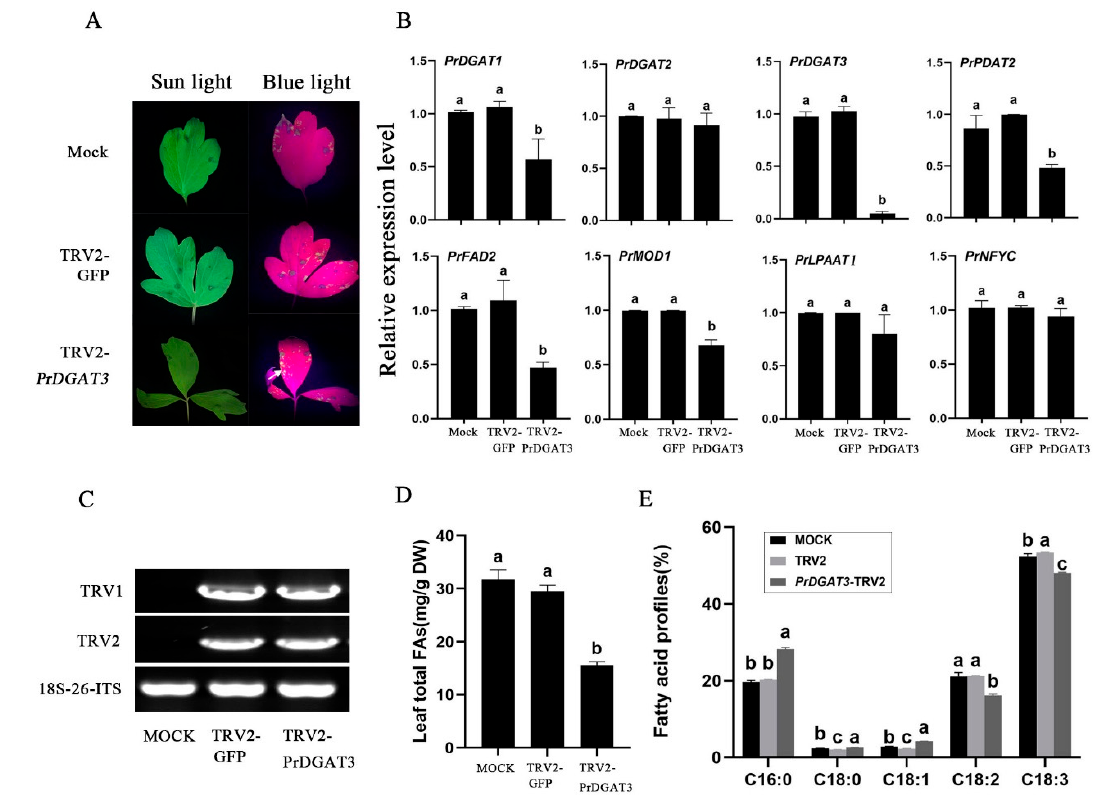
Figure 5. Reduced expression of PrDGAT3 in Paeonia rockii reduces the oil content and affects fatty acid composition as well as relative gene expression. ( A ) Image of P. rockii leaves infected with TRV2- GFP or TRV2- PrDGAT3-GFP at 6 days post-infiltration under blue light. ( B ) Comparison of the expression levels of fatty acid and TAG biosynthetic genes among the Mock, TRV2- GFP control, and PrDGAT3 -silenced plants. ( C ) RT-PCR analysis of TRV1 and TRV2 accumulation levels in P. rockii leaf tissue at 2 weeks post-infiltration. ( D ) Total oil content in P. rockii leaves among the Mock, TRV2- GFP control, and PrDGAT3 -silenced plants (% dry weight). ( E ) Major fatty acid profiles in TAG among the Mock, TRV2- GFP control, and PrDGAT3 -silenced plants. Values are mean ± SD ( n = 3). Different letters indicate significant difference at p < 0.05, as confirmed by one-way ANOVA with Tukey’s post hoc